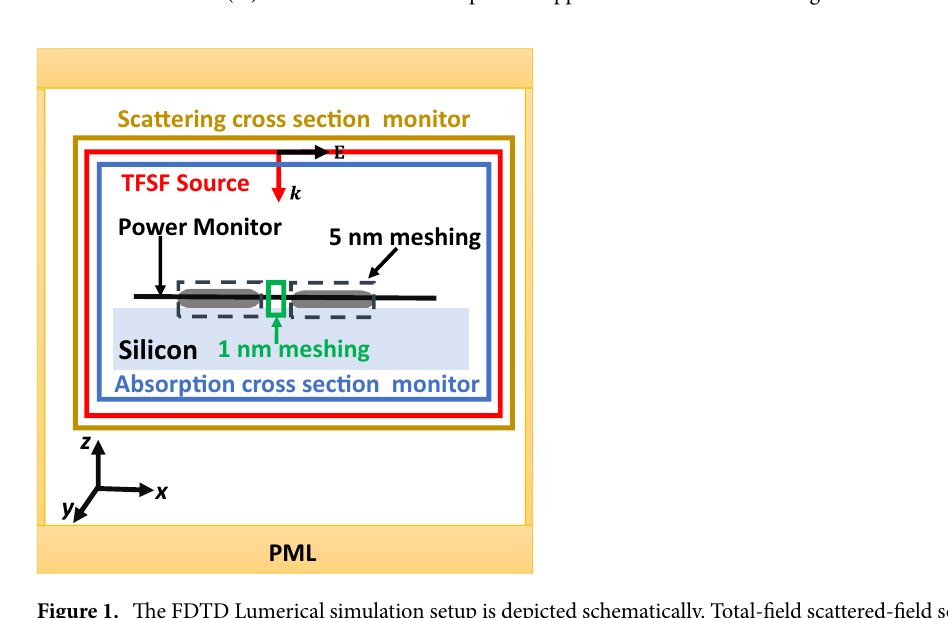
Figure 1. The FDTD Lumerical simulation setup is depicted schematically. Total-field scattered-field source (TFSF) is applied. To model a relatively large substrate, silicon extends beyond the simulation region and PML